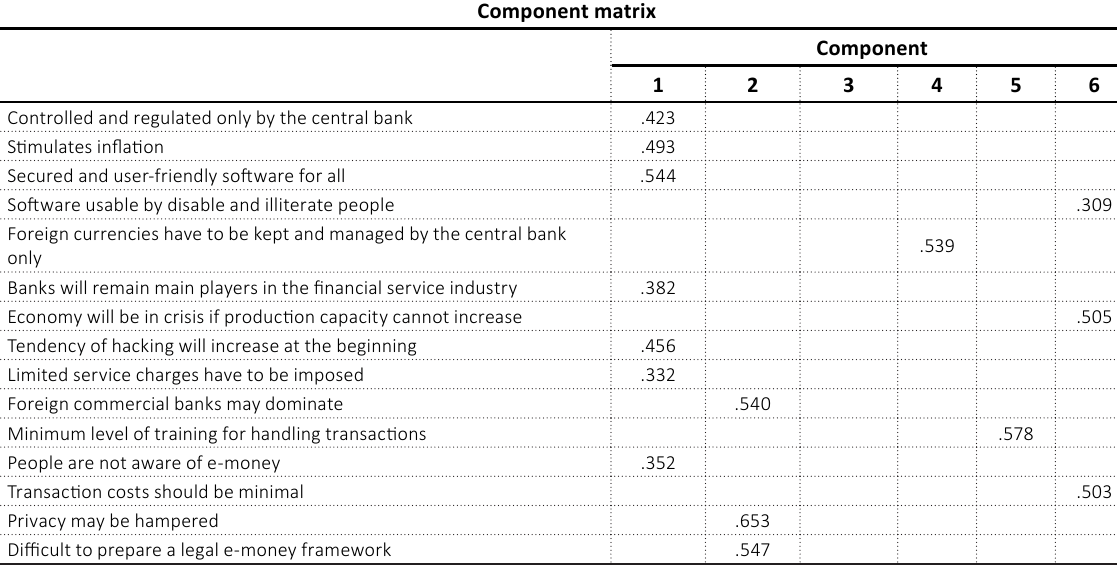
Table A2. Challenges of instigating full-fledged e-money in Bangladesh Component